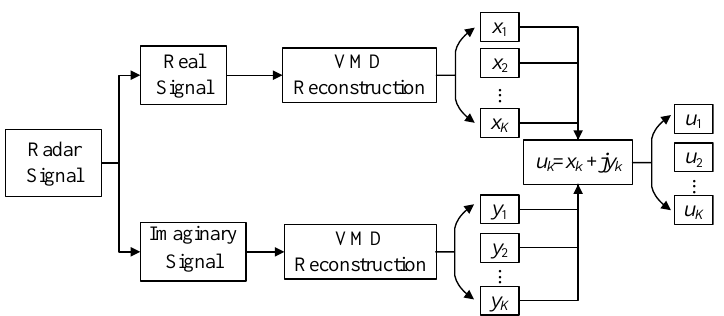
Figure 7. Basic process of radar echo CVMD